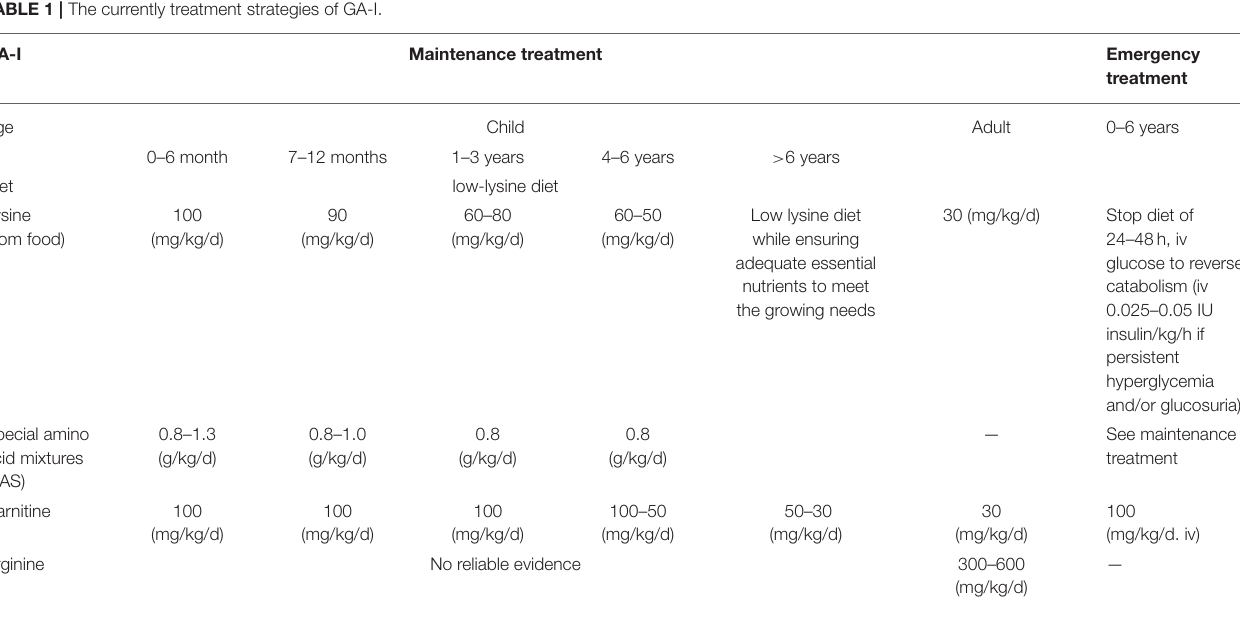
TABLE 1 | The currently treatment strategies of